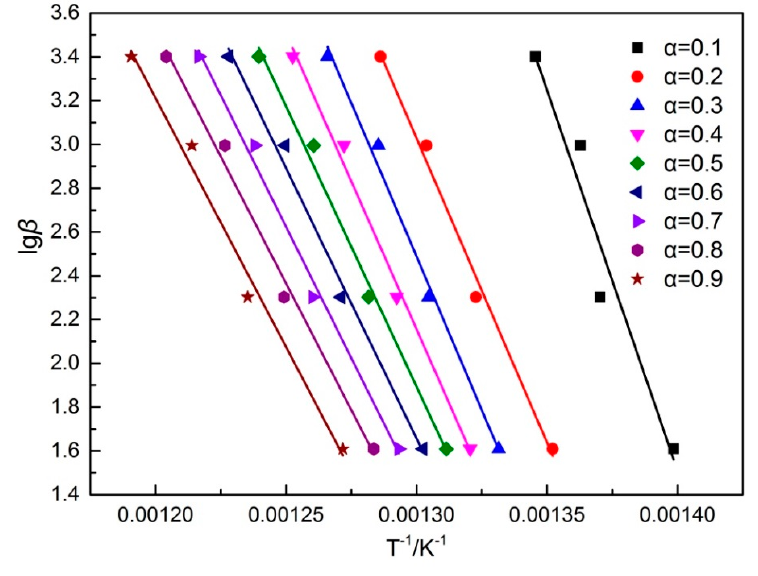
Figure 5. Regression lines for various conversion fraction based on FWO method. Table 4. Activation energies estimated by FWO method at different conversion fraction.